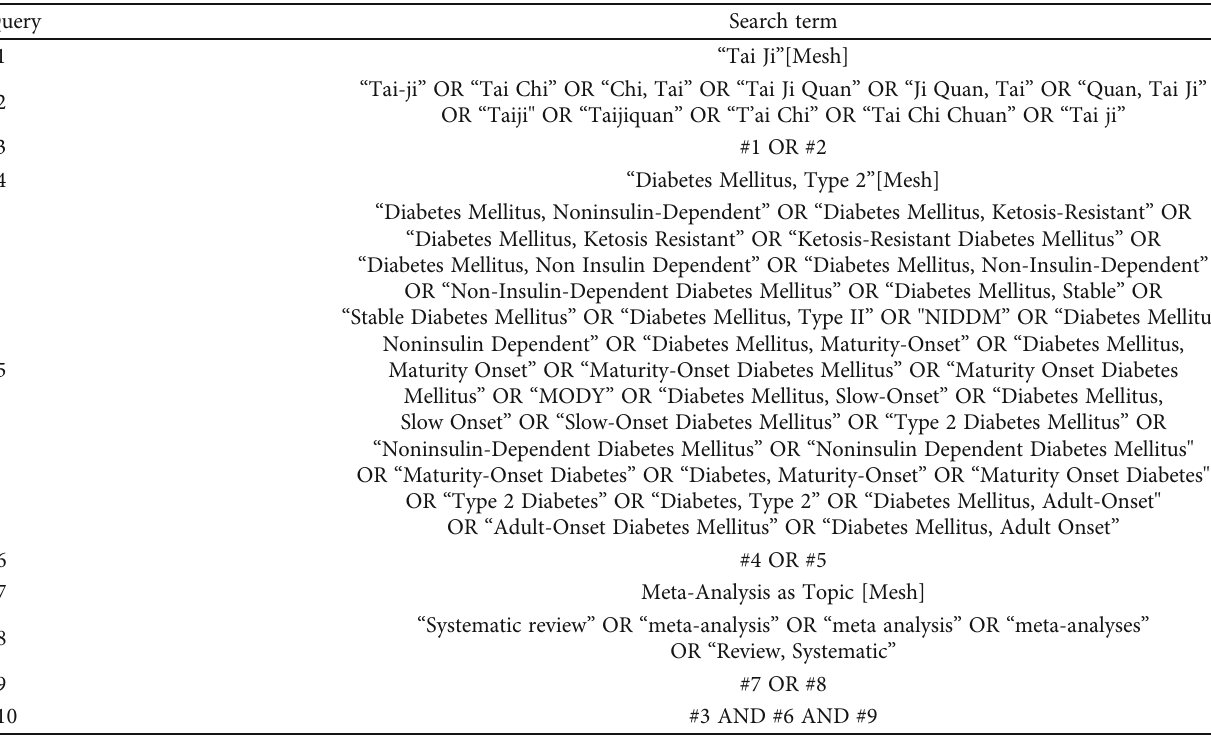
Table 1: Search strategy for the PubMed